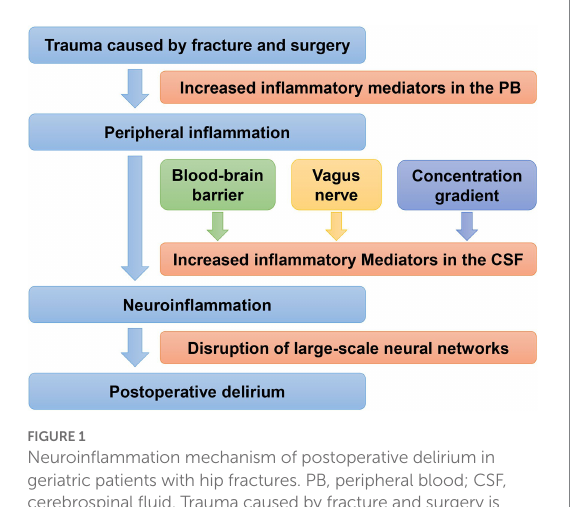
FIGURE 1 Neuroinflammation mechanism of postoperative delirium in geriatric patients with hip fractures. PB, peripheral blood; CSF, cerebrospinal fluid. Trauma caused by fracture and surgery is associated with increased systemic inflammatory mediators, which are transported from the periphery to the brain via three primary pathways, resulting in neuroinflammation, and finally lead to